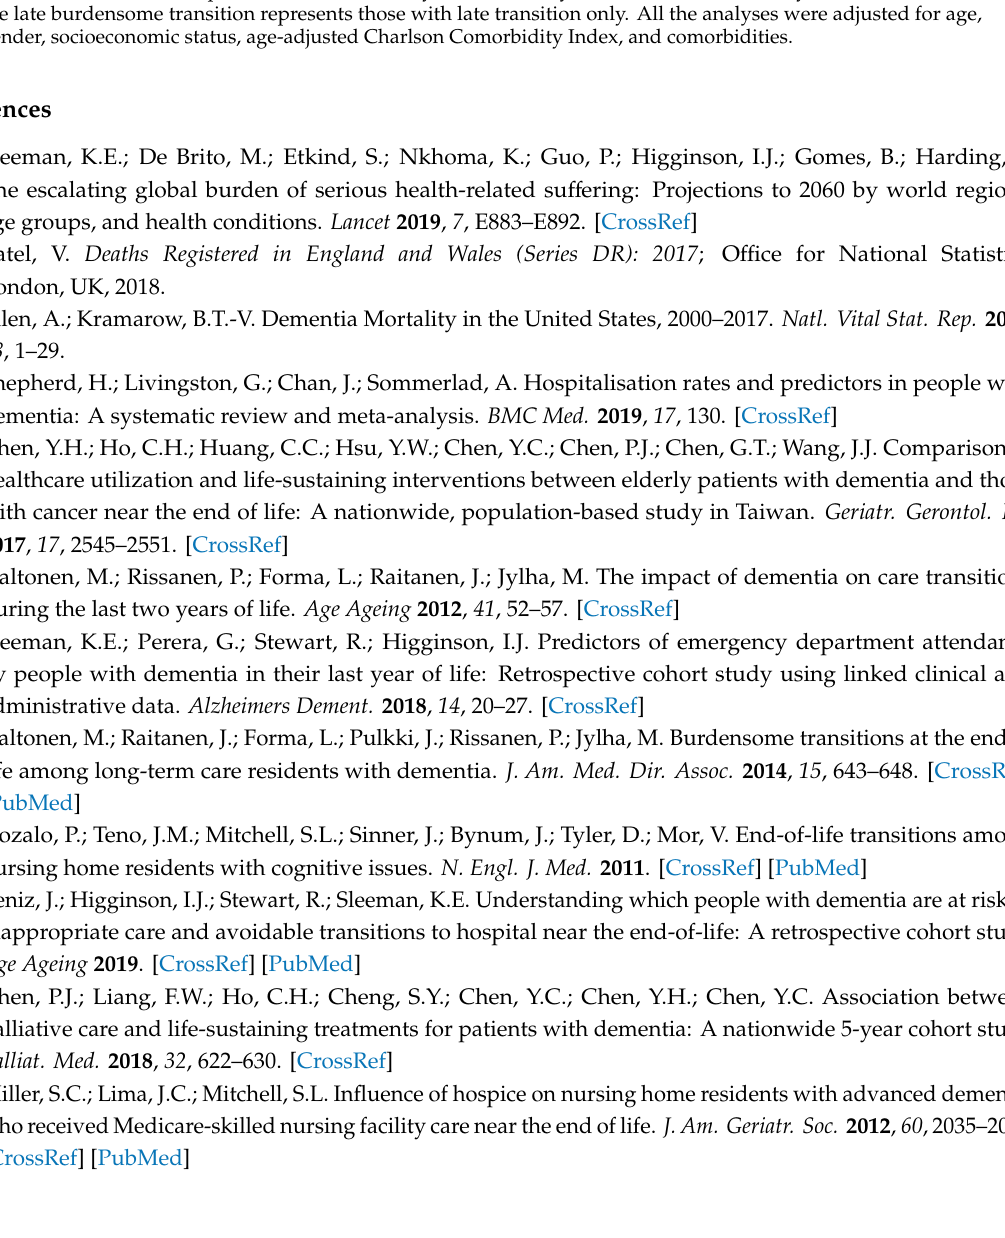
All people in the matched cases